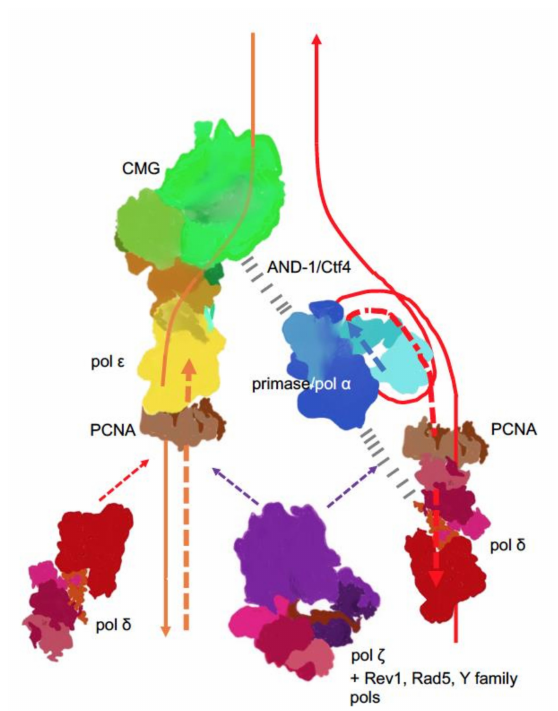
Figure4. Mainplayersattheeukaryoticreplicationfork.